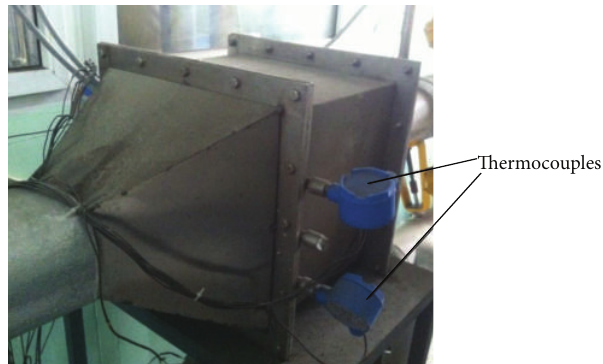
Figure 4: Exterior of the heat exchanger.